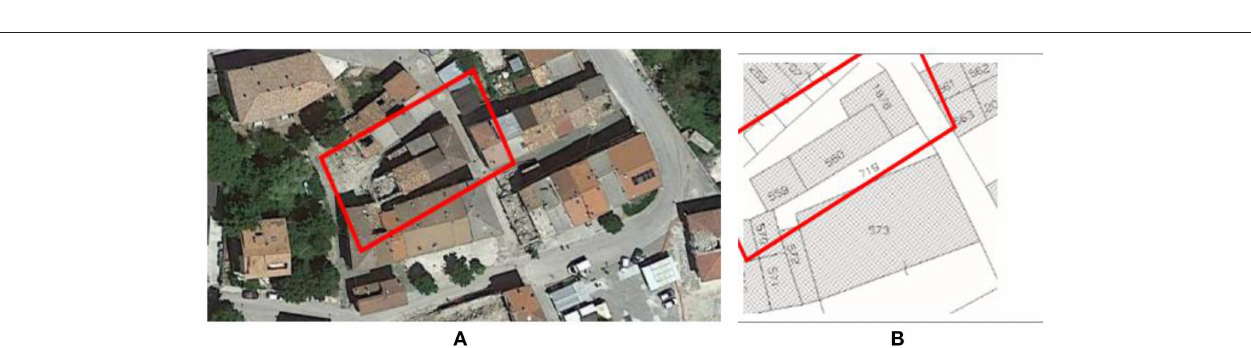
FIGURE 12 | Comparison between the observed frequencies and the binomial distributions evaluated according to the observed and the predicted mean damage.